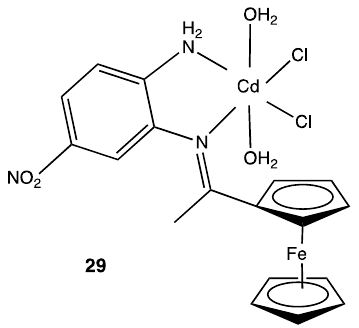
Figure 14. Cd(II) complex with antitumoral activity IC 50 50 µ